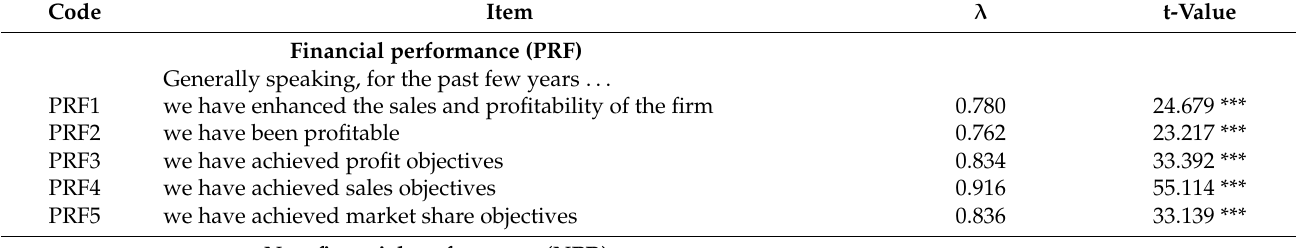
Table 2. Indicators’ standardized loadings and t-values.